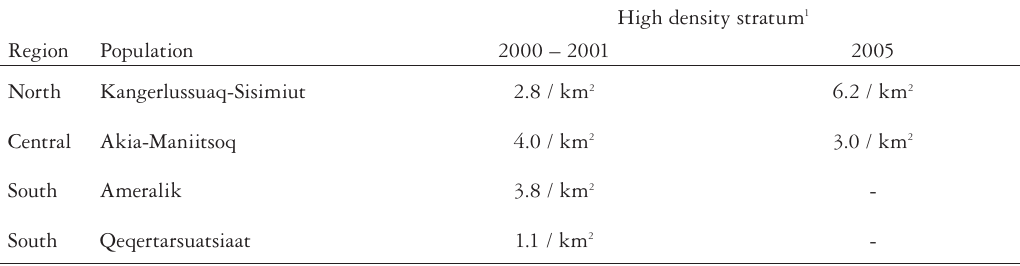
Table 2. Recent estimates of caribou density in four West Greenland herds. Region